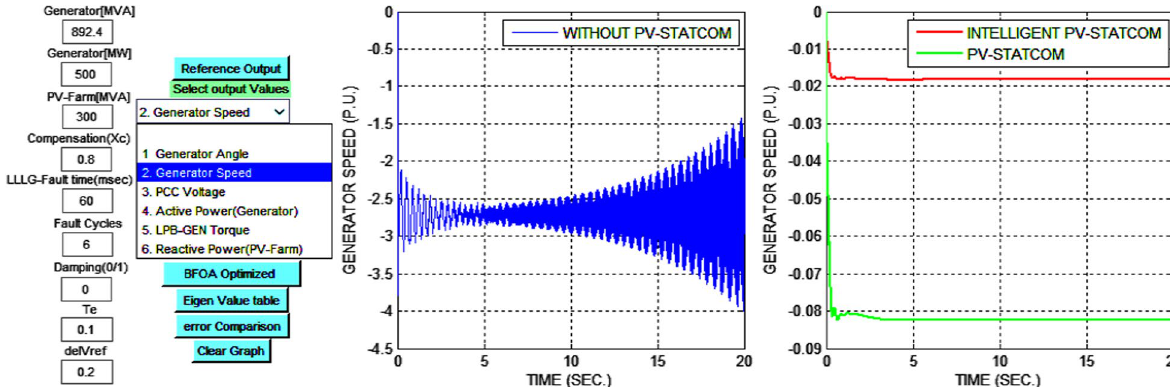
Fig. 11 Rotor speed deviation (Δω)